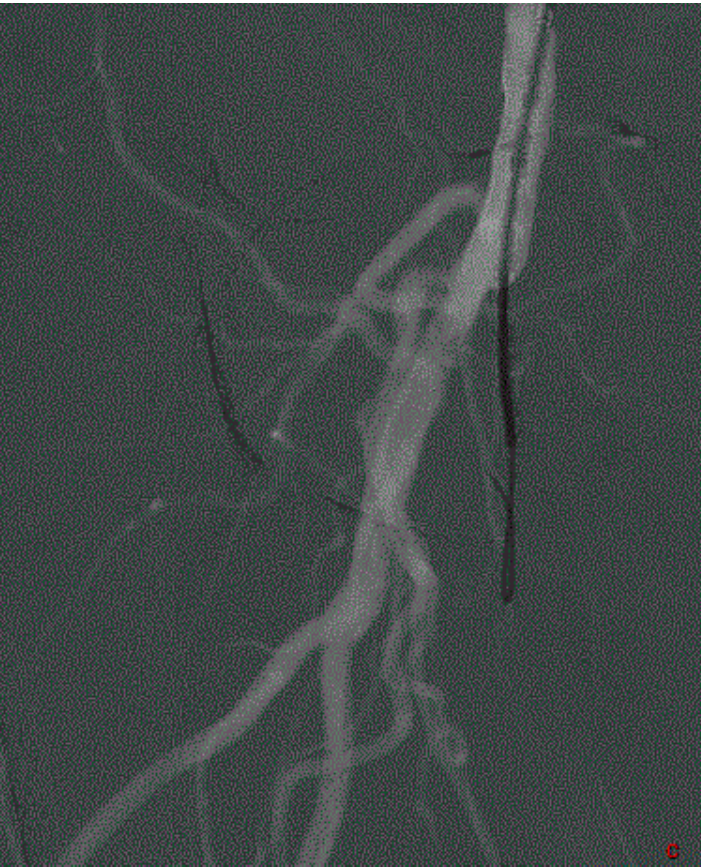
Figure 4. Subintimal recanalization of a long femoropopliteal occlusion with the loop